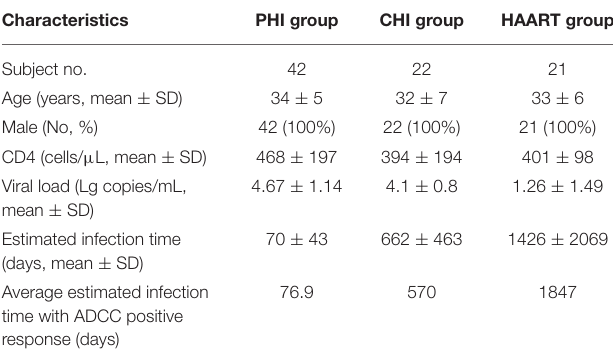
TABLE 1 | Clinical characteristics of subjects enrolled in this